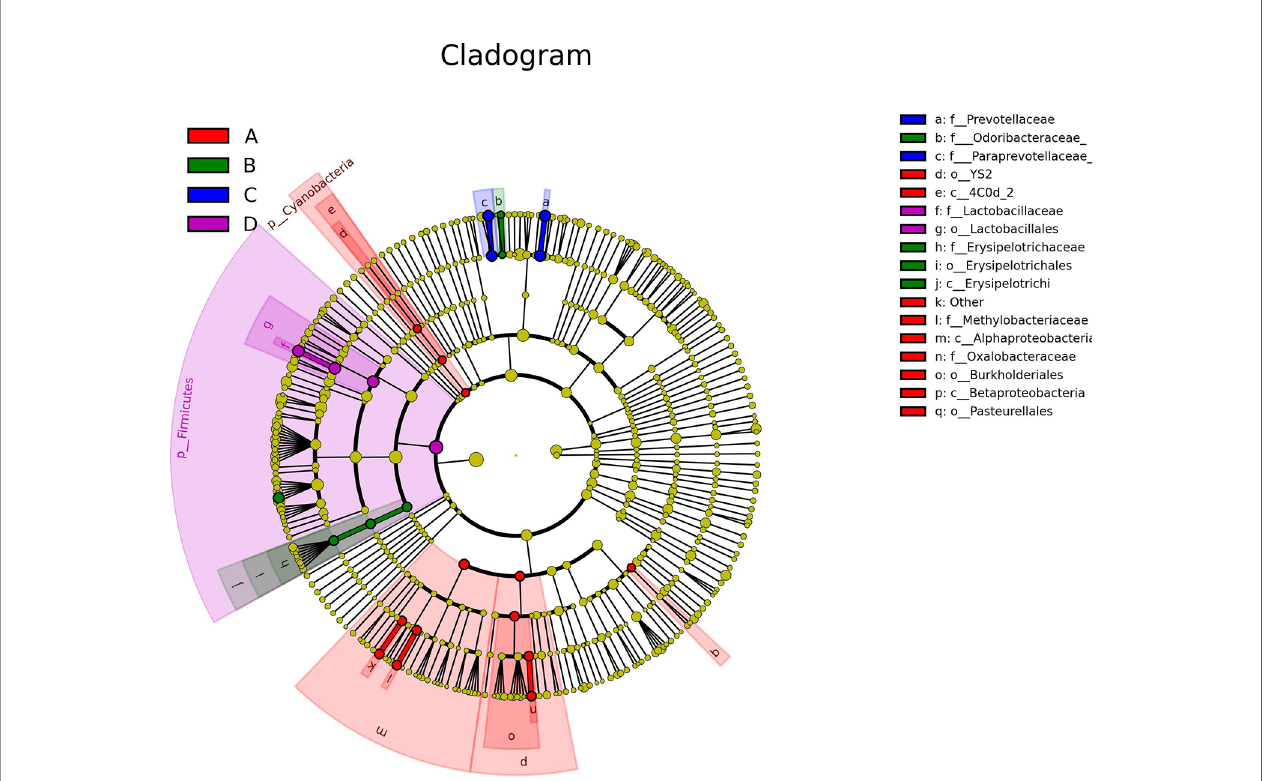
FIGURE 6 | Therapeutic effects of different treatments on the structure and key phylotypes of the GM displayed by cladogram based on LefSe analysis (n = 10). The levels represent, from the inner to outer rings, phylum, class, order, family, genus and species, which can identify the speci fi c community or species that make a signi fi cant difference in sample classi fi cation. (A-D) represent Sham, OVX, OVX+ICA and OVX+E2 groups,